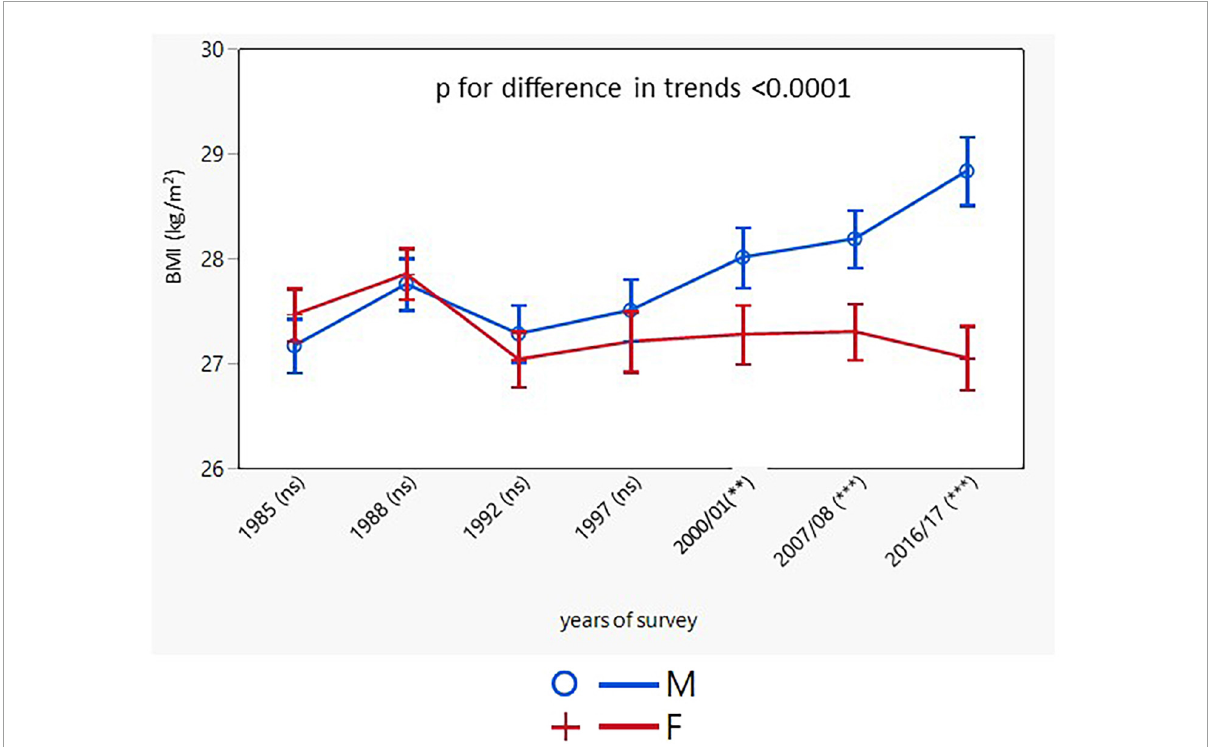
FIGURE1 Age-adjusted trends in BMI (95% confidence interval). BMI, body mass index; M, males; F, females; p for differences in trends between males and females. NS or asterisks in brackets after survey years indicates the sex differences in respective surveys after Bonferroni correction; ** p < 0.01; *** p <